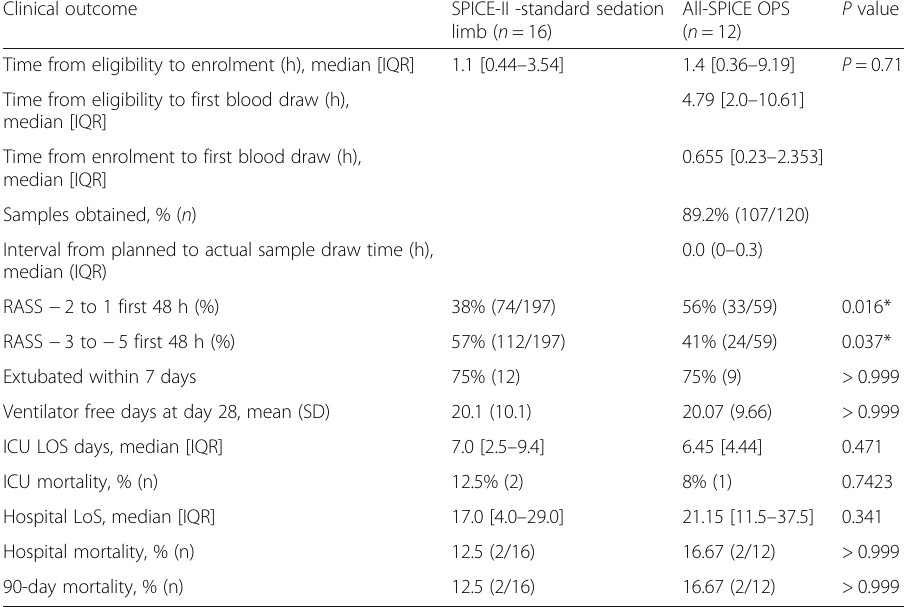
Table 3 Feasibility and clinical outcomes Clinical